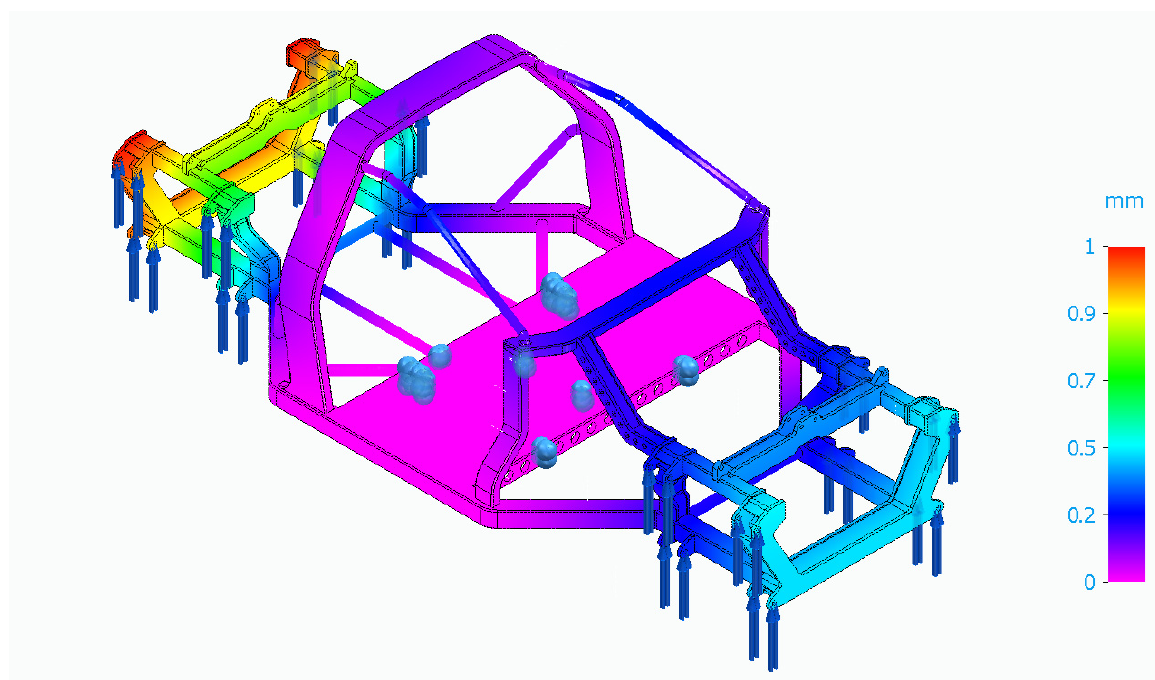
Figure 23. FEM Analysis with 1200 N load and 0.9 mm deformation.